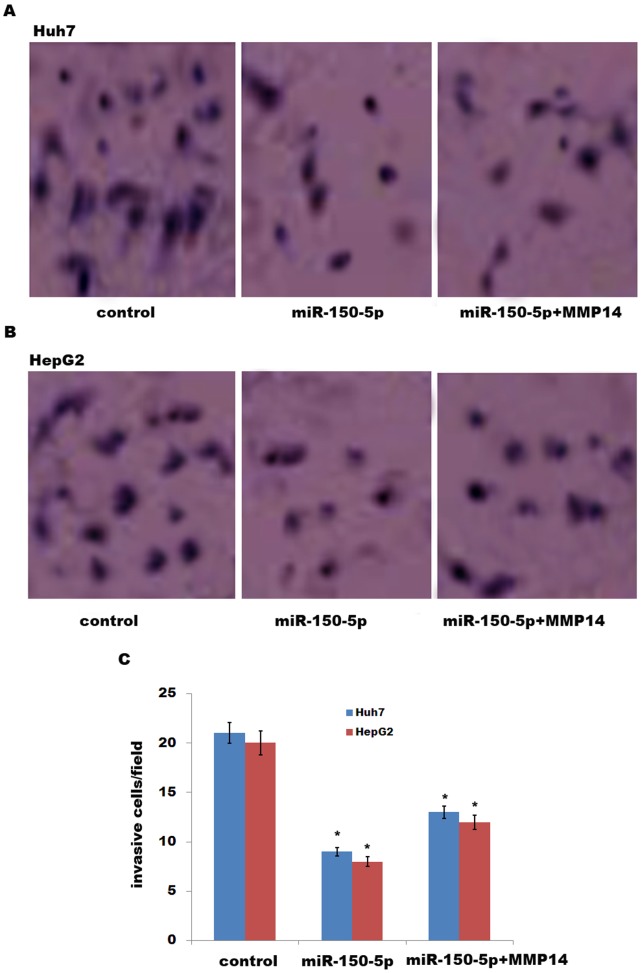
miR-150-5p inhibits hepatoma cell invasion by targeting MMP14.